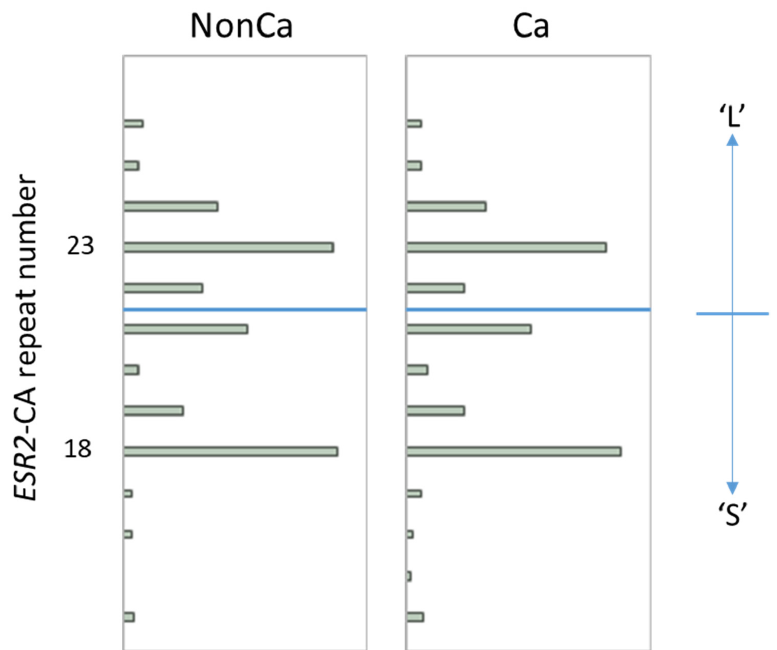
Figure 1. The distribution of ESR2 cytosine-adenine ( ESR2 -CA) allele frequency in non-cancerous (NonCa) and cancerous (Ca) tissue, with boxplots. Two major peaks were observed at 18 and 23 in both tissue categories, which is largely consistent with the results of other studies in the Japanese population. Alleles with CA repeats <22 and ≥ 22 were designated as ‘S’ and ‘L’, respectively, resulting in genotypes SS, LS, and LL. Genotypes ‘SL’ and ‘LL’ were combined as ‘nSS’.